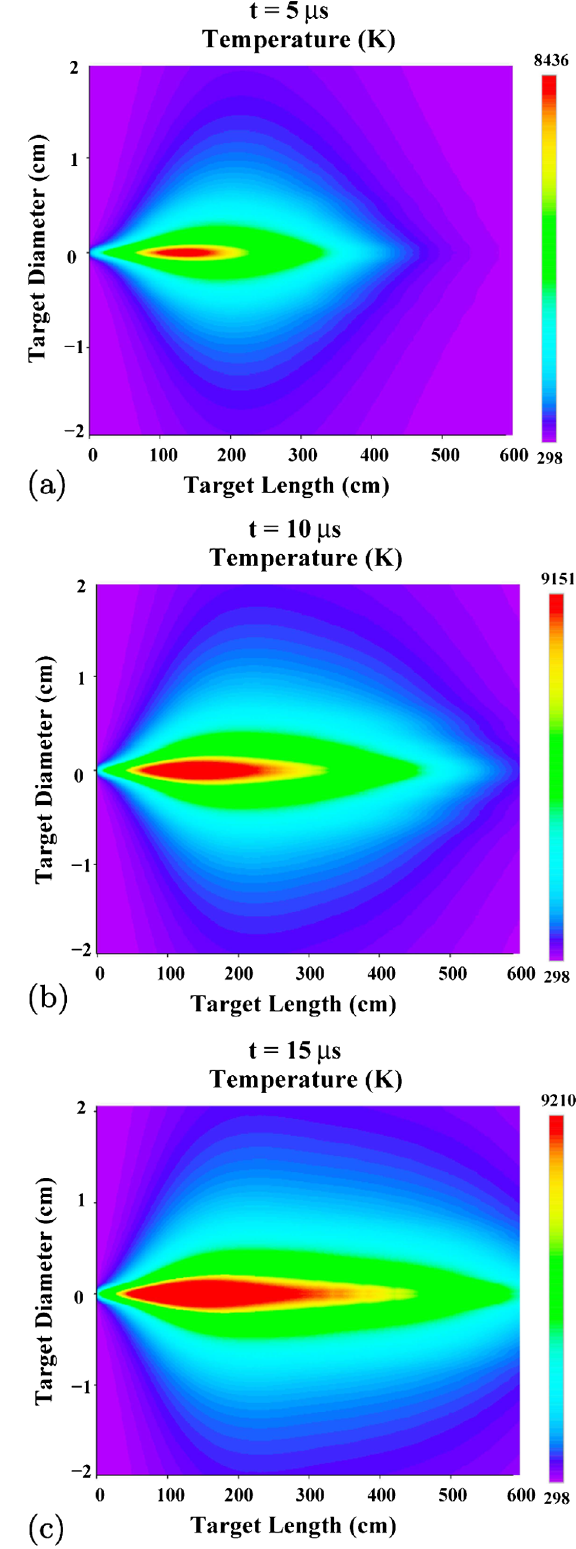
FIG. 5. Temperature distribution calculated by BIG2 in the carbon cylinder, r ¼ 5 cm , L ¼ 6 m , irradiated by the LHC beam at the left face; (a) at t ¼ 5 (cid:2) s ; (b) at t ¼ 10 (cid:2) s , and (c) at t ¼ 15 (cid:2) s